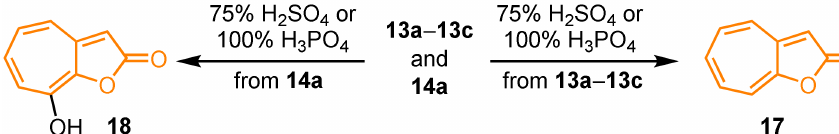
Scheme 5. Decarboxylation and deacetylation of function at the